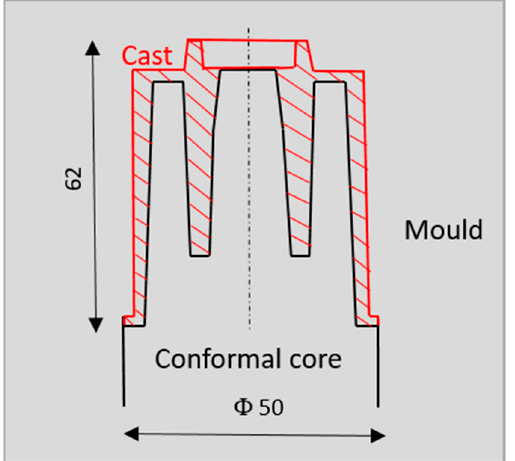
Figure 2. The position of the mould core, mould, and casting in the geometrical model.